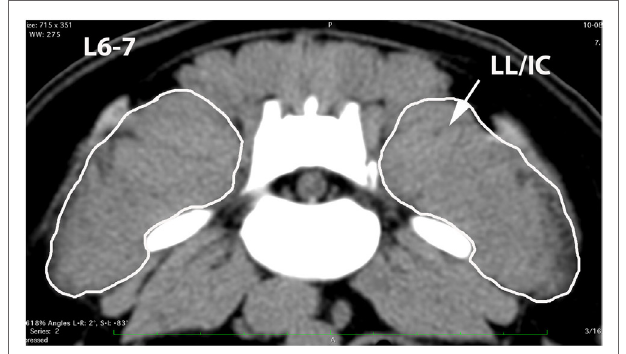
FIGURe 8 | transverse Ct image at the level of L6–7, illustrating margins of the combined longissimus lumborum/iliocostalis (LL/IC) muscle group .